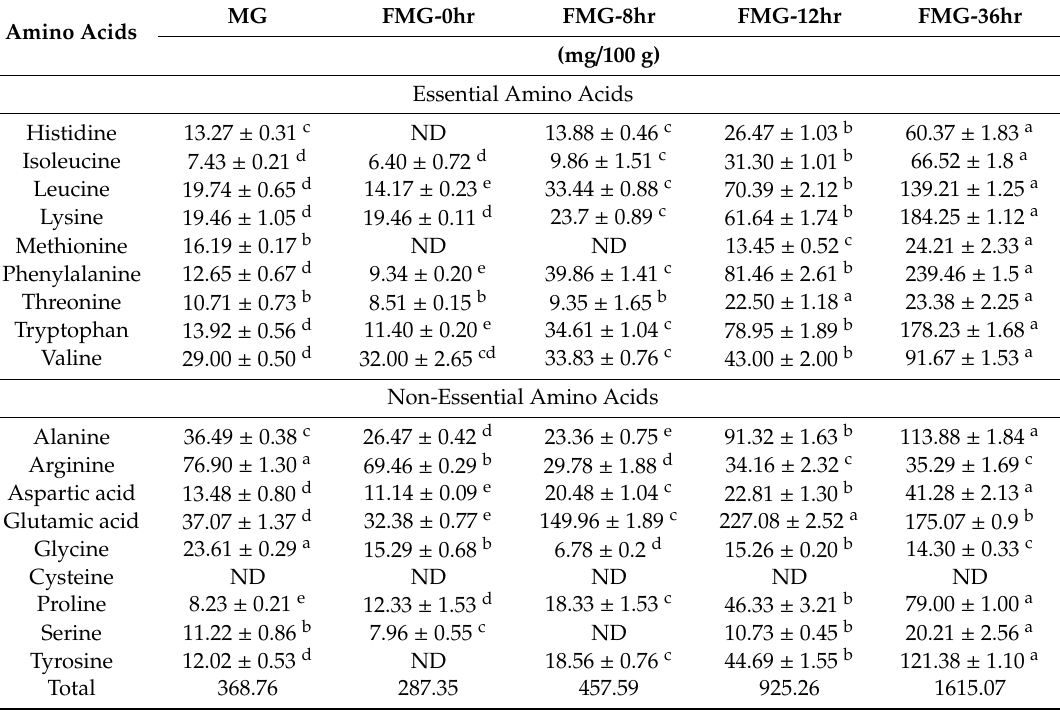
Table 1. The contents of free amino acids during the fermentation of MG. Amino Acids